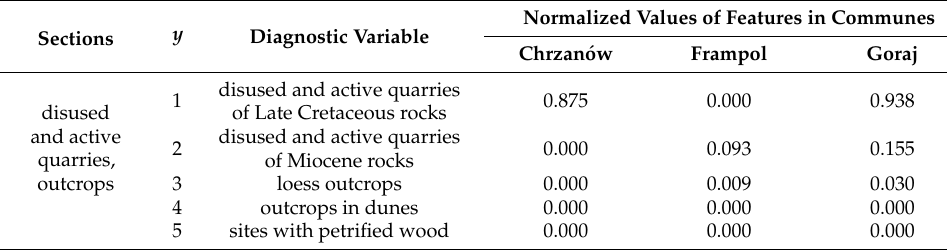
Table 3. Normalized values of the tourism potential elements in some